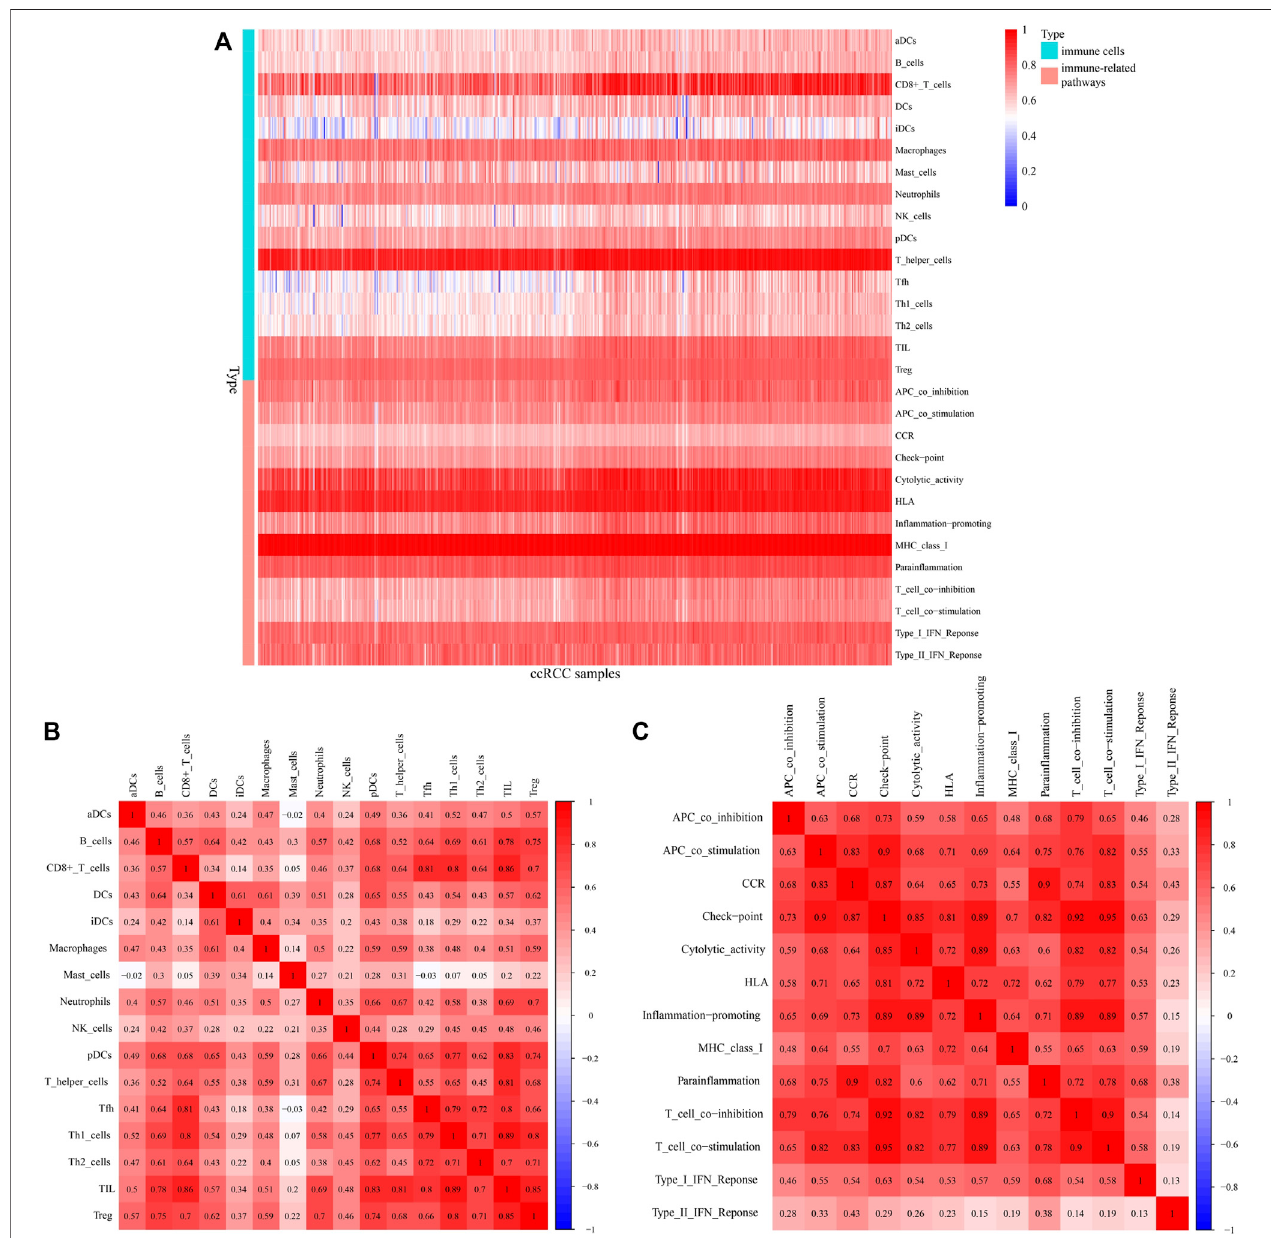
FIGURE 9 | Immunocorrelation analysis. (A) Heatmap of in fi ltration scores of immune cells and pathways. (B,C) Correlations between different immune cells and pathways, with redder color indicating a higher degree of correlation.